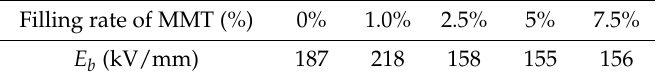
Table 1. The electric breakdown strength of montmorillonite (MMT) pressboard